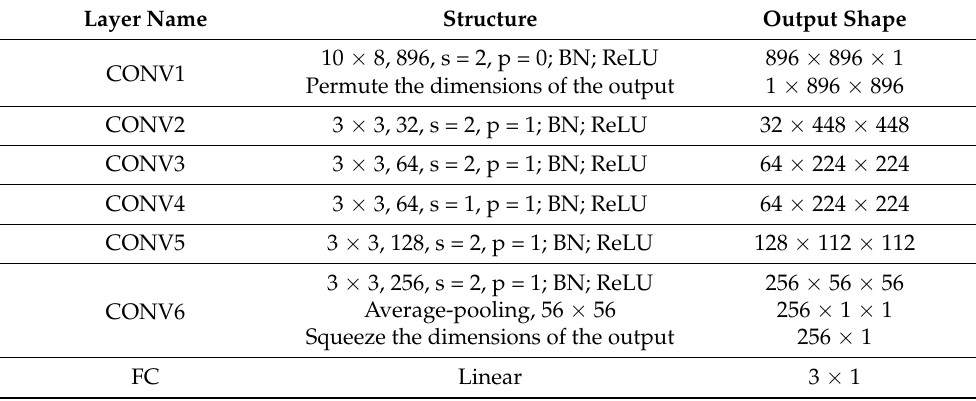
Table 3. Architecture of CNN-7 for the volume flow rate